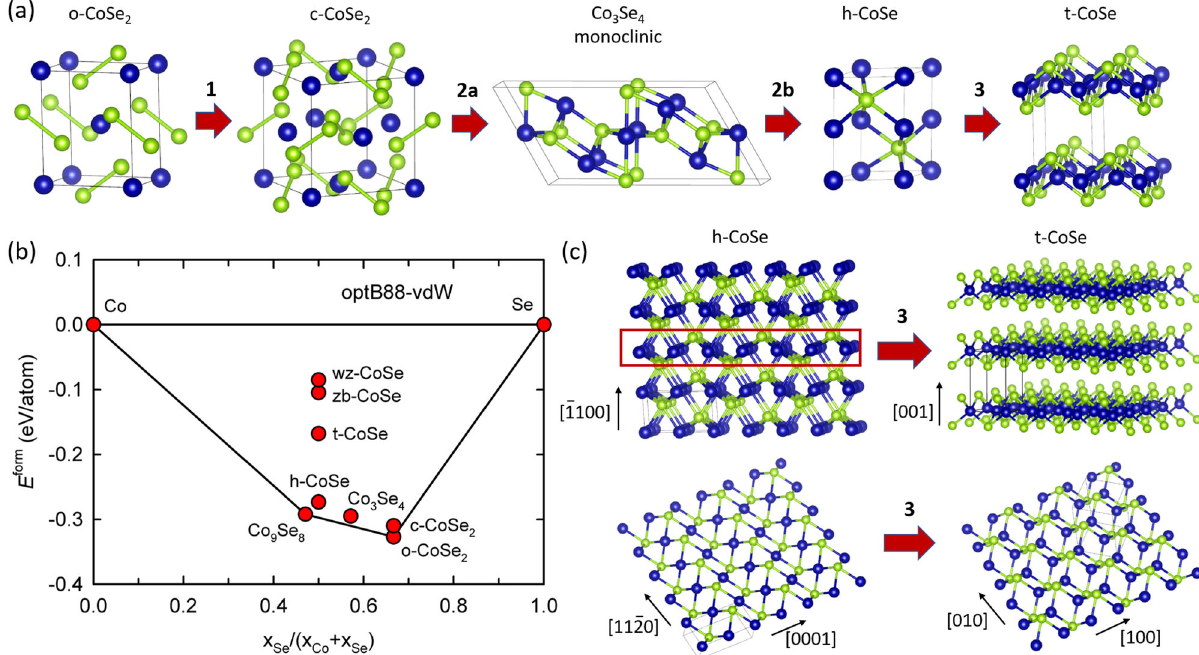
Fig. 6 Structures and energetics of the Co x Se y phases. a Unit cells of the crystal structures involved in the transformations, going from orthorhombic to cubic-CoSe 2 , to monoclinic Co 3 Se 4 , to hexagonal-CoSe, and fi nally tetragonal-CoSe. b Stability phase diagram calculated using the optB88-vdW functional; the formation energies are also listed in Supplementary Table 4. The bottom black line indicates the common tangent line connecting the most stable phases. c Visualization of a possible transformation pathway from the hexagonal to the (cid:4) (cid:5) planes in h-CoSe are strongly resembling the (001) planes in the t-CoSe phase. Structure fi les tetragonal phase (transformation 3). The 1100 of all DFT-optimized phases are provided as Supplementary Data